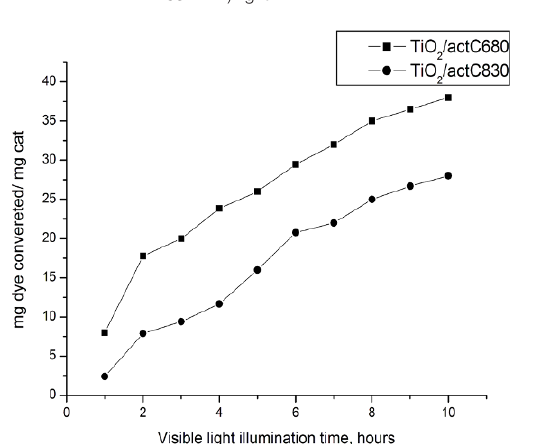
Figure 8. Comparison of the photocatalytic degradation activities of the two composite samples TiO 680 o C and at 830 o C under illumination with visible light.